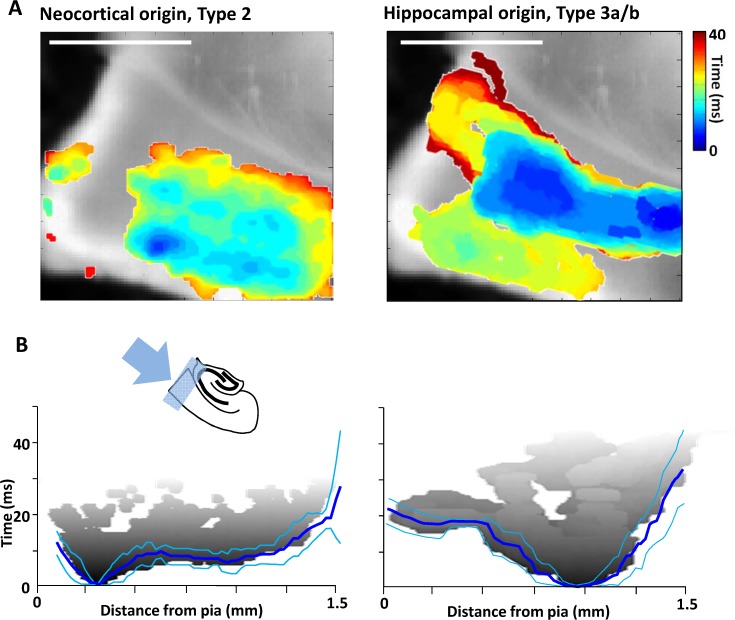
Comparison of propagation dynamics within neocortex.
A. Spatiotemporal maps of activity spread through neocortical laminae for events originating in cortex (Type 2 events, left panel) and those spreading to cortex from hippocampus (Type 3 events with (3b) or without (3a) backpropagation, right panel). Only areas demonstrating activity over threshold are represented on the colormap, overlaid on the transmitted light (non-fluorescent) slice image. Colormap represents time from event onset (cool-hot). B. Mean event spread (n = 6 slices, left panel, n-5 slices right panel) viewed along the radial cortical axis from pia to subcortical while matter (as illustrated by the cartoon insert). An individual example of an interictal wavefront (1st threshold crossing) is shown in gray, blue lines show mean ± s.e.mean. Note the superficial focus for events of neocortical origin and the deep focus for events propagating from hippocampus.